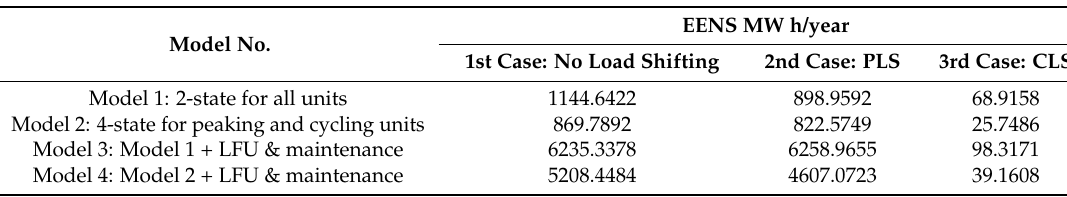
Table 4. Proposed models of PLS and